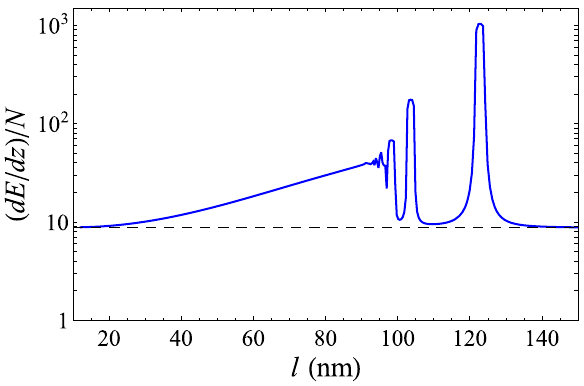
FIG. 4. Dependence of the ensemble ionization loss on the microbunching period l in hydrogen for d L ¼ 24 μ m, and γ ≫ I= ω